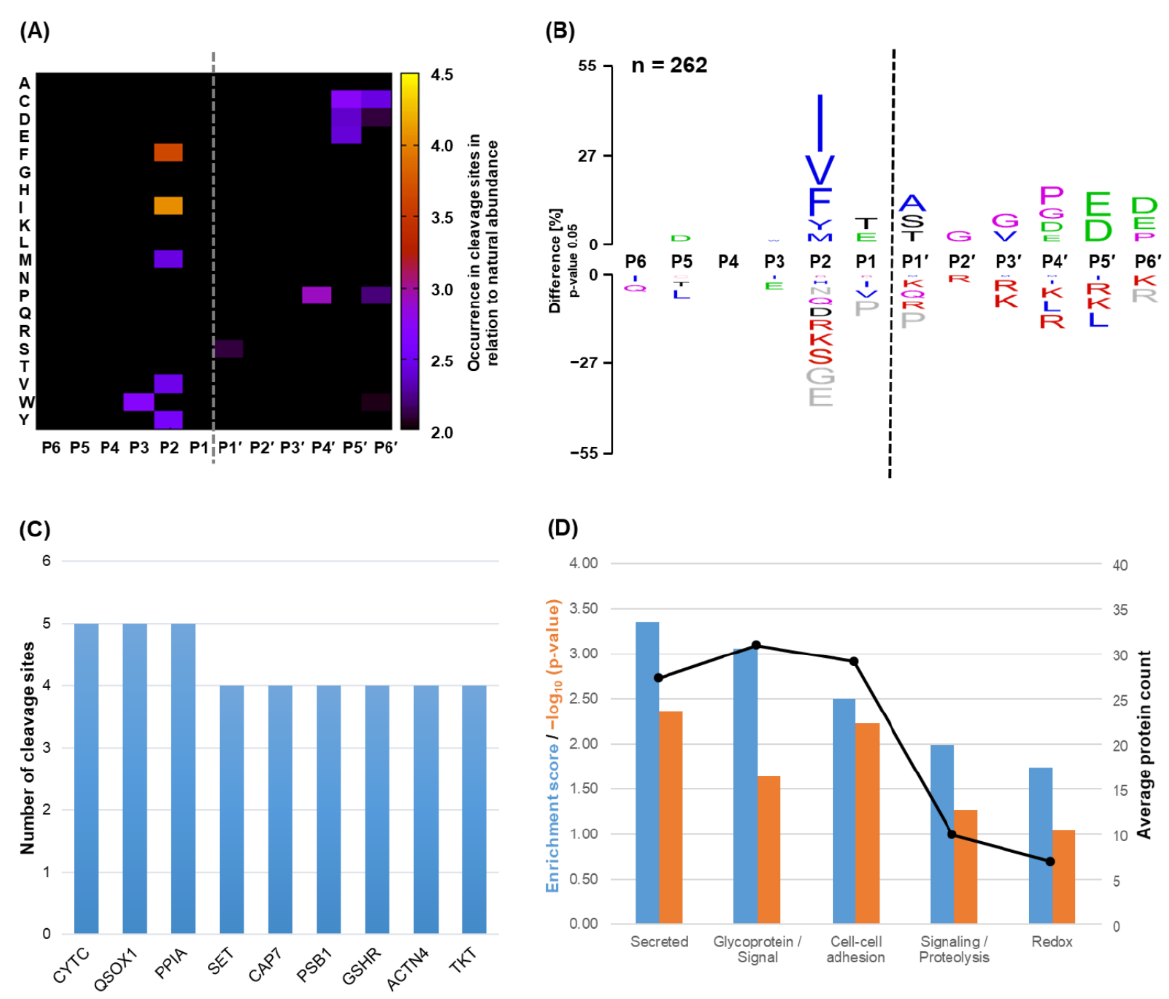
Figure 3. Identification of cleavage sites in intact proteins derived from the monocytic secretome. A total of 262 unique cleavage sites were identified by the N-terminomics workflow, combining cleavages identified after two individual experiments employing subsequent tryptic and GluC digestion, respectively. Based on this combined data, the heatmap in panel ( A ) depicts the fold- change in occurrence of specific amino acids at certain positions in the substrate in relation to their natural abundance. ( B ) Respective sequence logo demonstrating the difference in percent of amino acids at specific positions in prime and non-prime sites ranging from P6 to P6 ′ . The amino acid color code is defined in the caption of Figure 2. ( C ) Top 9 proteins (UniProt abbreviations) in the secretome of monocytes ranked after the number of SpeB cleavage sites identified. ( D ) Top 5 enriched annotation clusters of proteins that were substrate to SpeB proteolysis based on enrichment analysis. The blue bar chart depicts the enrichment score, whereas the orange bars indicate the average negative log 10 p -value. The interpolated points indicate the average number of proteins involved in the respective annotation cluster that were found to be proteolytically processed.